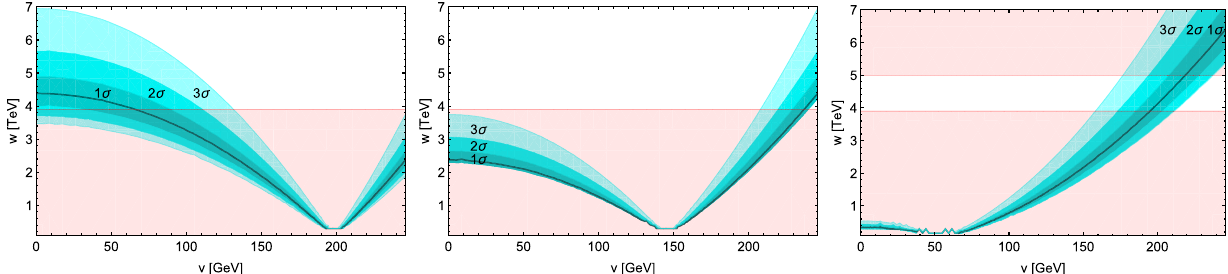
Fig. 1 Viable ( v,w ) regimes bounded by the CDF W -boson mass at (rightpanel),wheretheFCNC(lowerlight-red)andLandaupole(upper 1 σ , 2 σ , and 3 σ ranges (in cyans), according to the 3-3-1 model with light-red, if applied) bounds are also √ √ −√ β = 1 / 3 (left panel), β = − 1 / 3 (middle panel), and β = 3